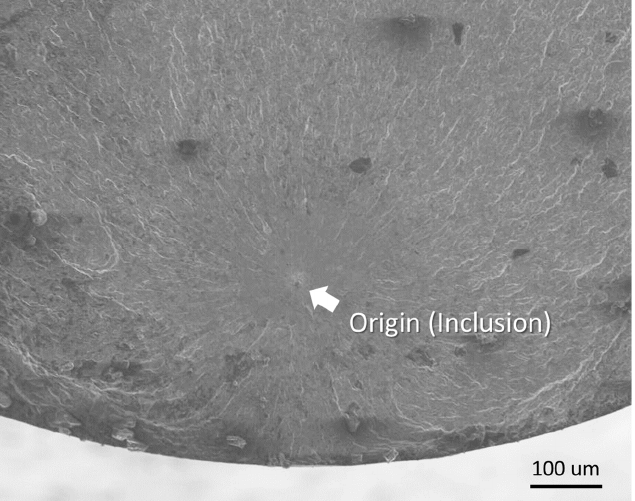
Figure 4. Fatigue origin of the specimen used for the repeated synchrotron radiation μ CT imaging.